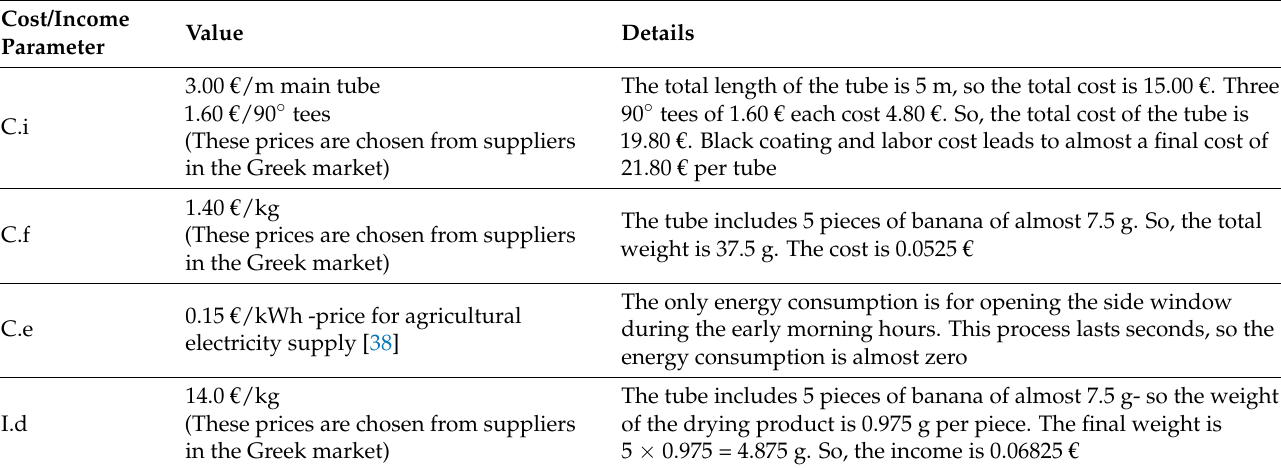
Table 7. Parameters for the P.B period of banana drying for the prototype examined case study.